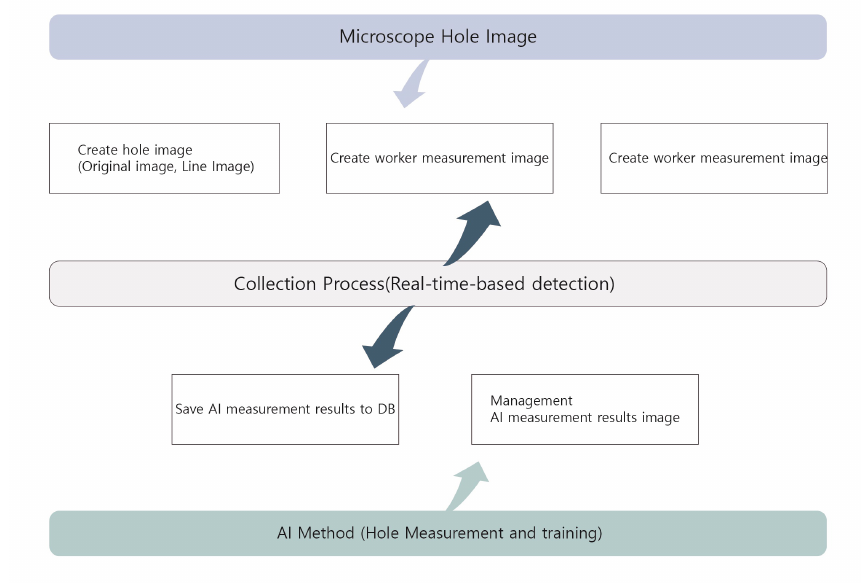
Figure 5. The architecture of our data gathering processor.